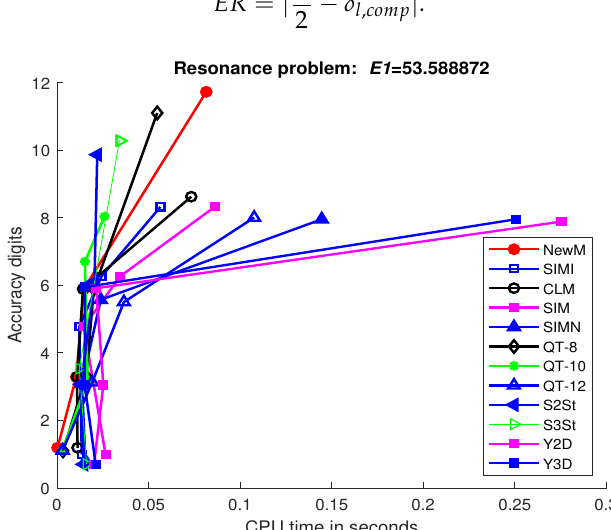
Figure 5. Efficiency of the compared methods for E 1 =